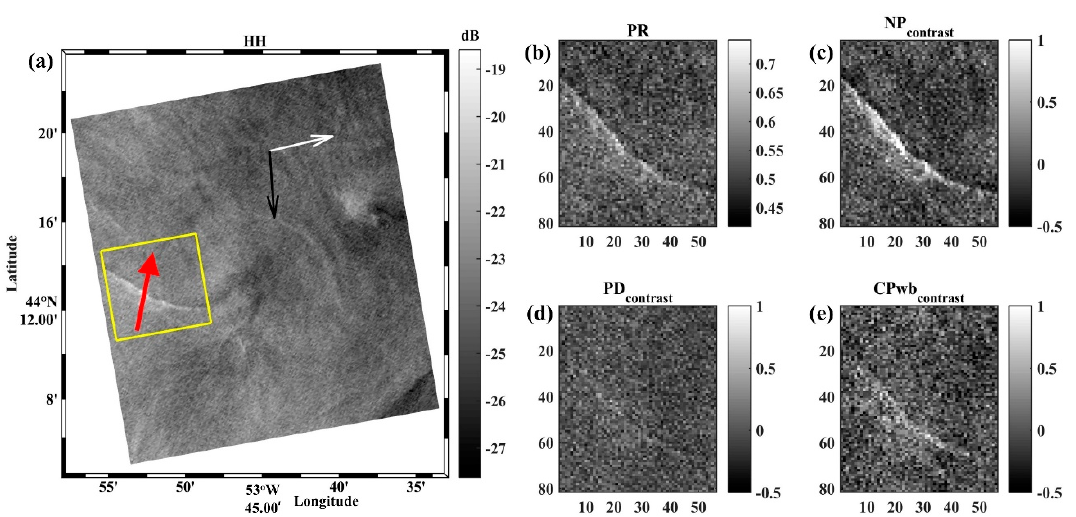
Figure 7. SAR images containing ocean current feature: ( a ) RS-2 SAR HH-polarized images (dB units) of an area of the East Coast of USA acquired at 21:30 UTC on April 26, 2009. The key parameters associated with the enlarged region of the yellow fragment in ( a ) are estimated as: ( b ) PR (linear units); ( c ) NP contrast; ( d ) PD contrast, and ( e ) CPwb contrast. The incidence angle, averaged wind speed and the angle between radar look direction and wind direction is about 39 degrees, 6 m / s and 96 degrees, respectively. RS-2 data are a product of MacDonald, Dettwiler, and Associates, Ltd. All rights reserved.